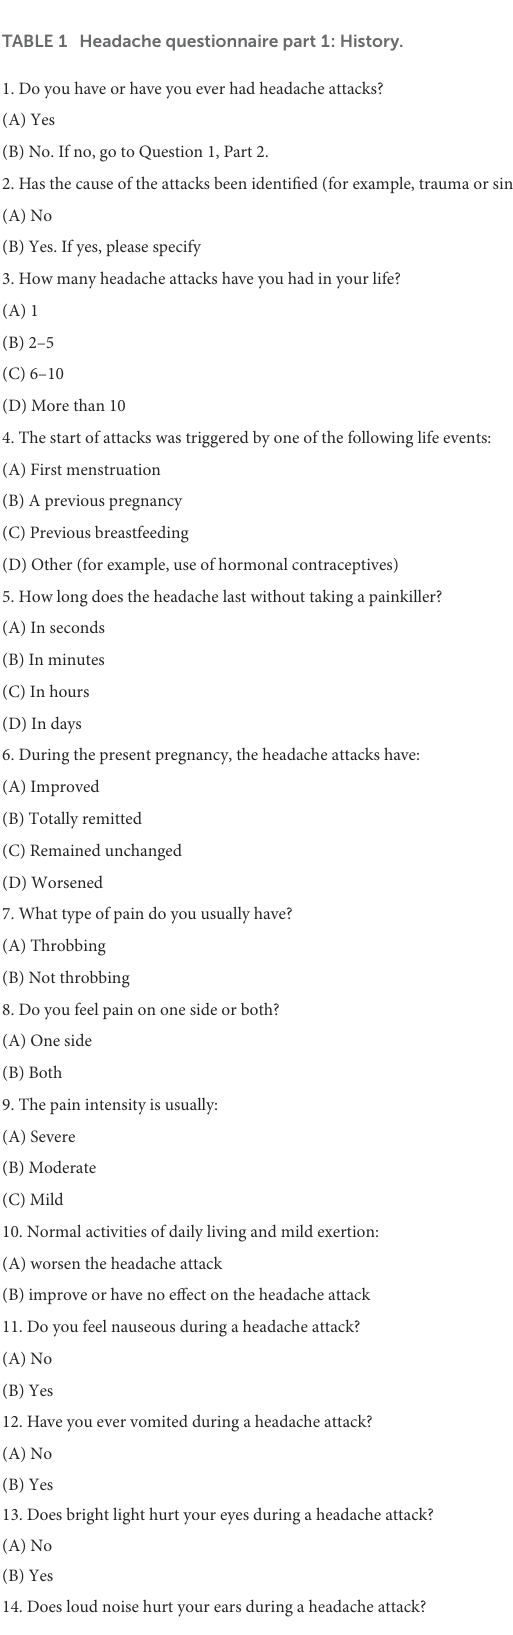
TABLE 1 Headache questionnaire part 1: